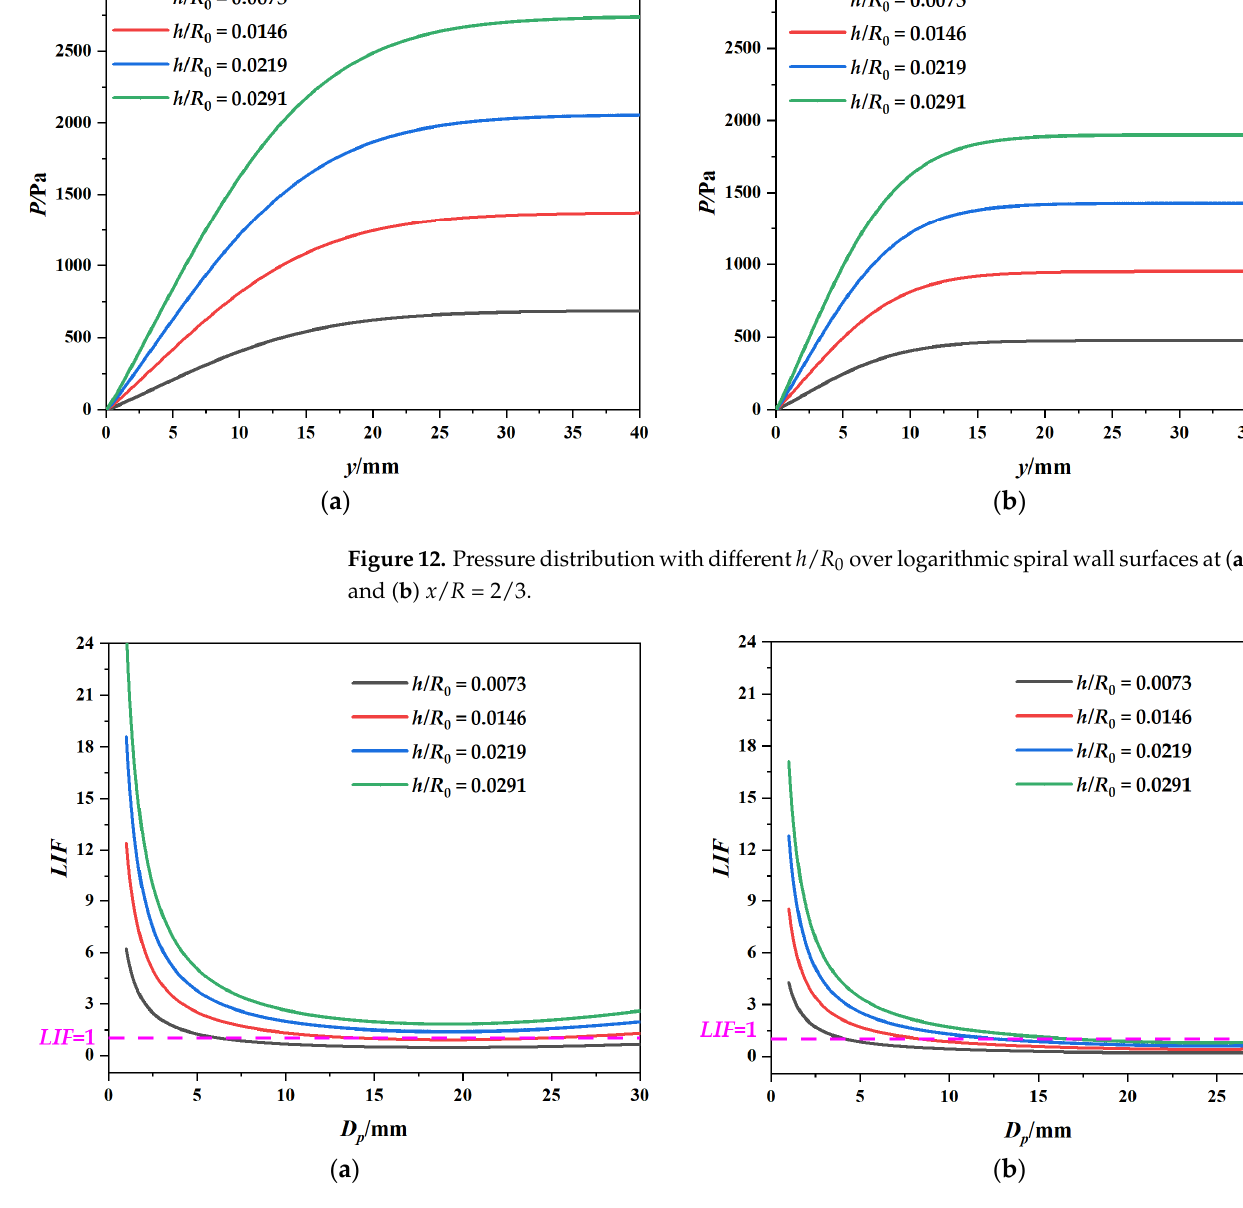
Figure 13. Lift index with different h / R 0 over logarithmic spiral wall surfaces at ( a ) x / R = 1 and ( b ) x / R = 2/3.